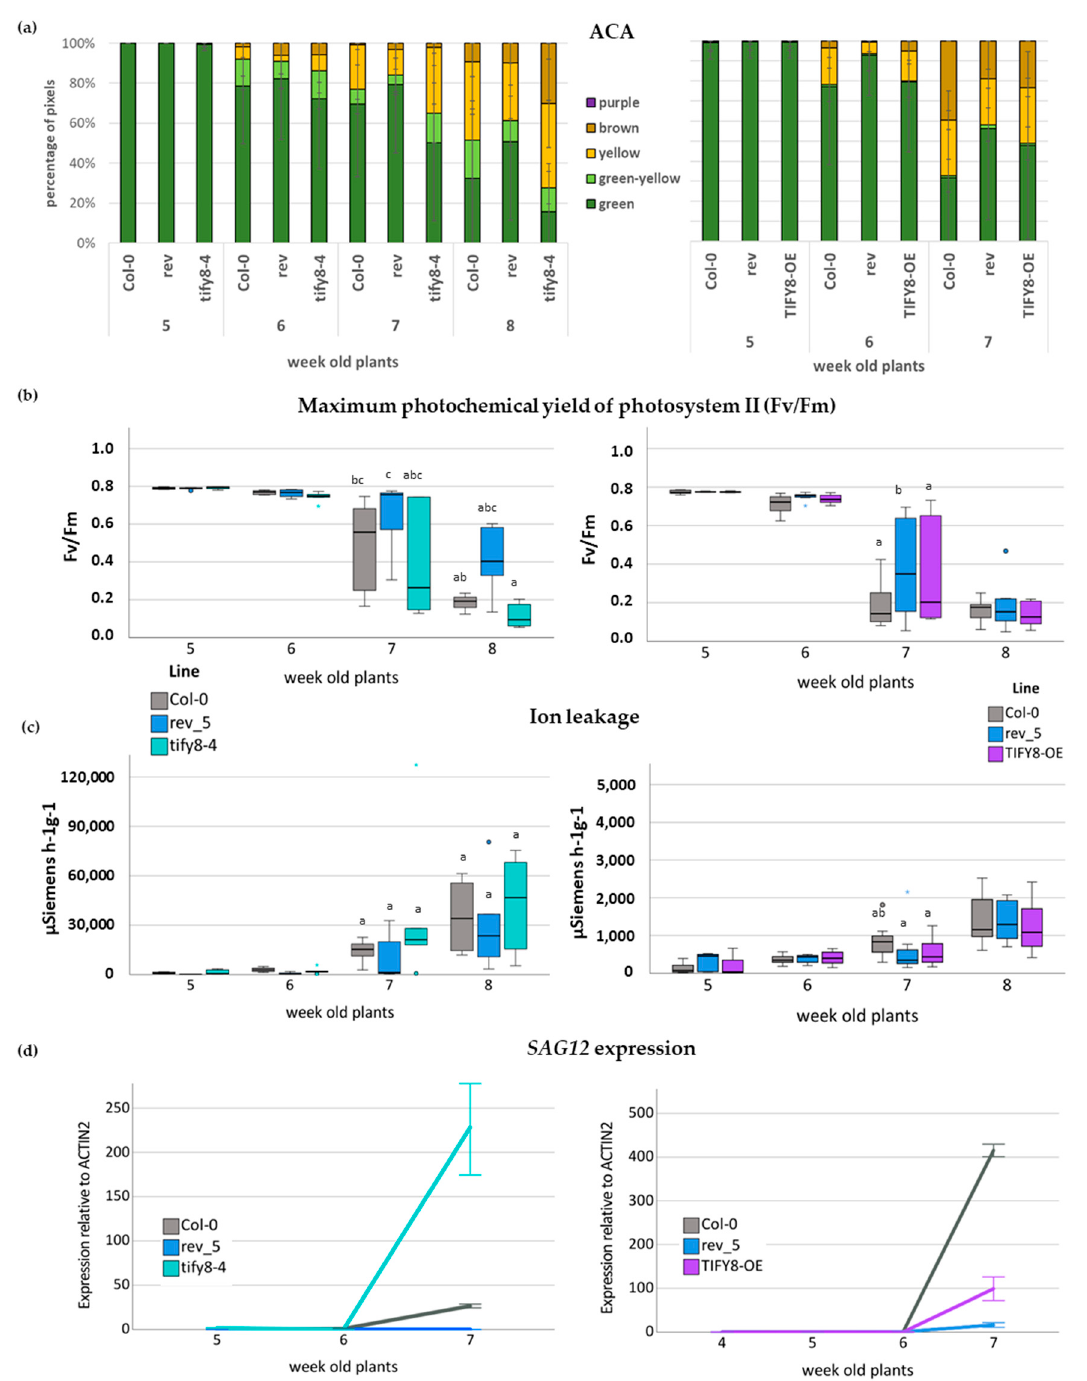
Figure 5. Photosynthetic parameters analyzed for the senescence phenotyping of tify8-4 and TIFY8 - OE compared to rev5 mutants and wildtype Col-0 plants. ( a ) The Automated Colorimetric Assay (ACA) to categorize the color of individual leaves of at least six plants pixelwise into five categories: green, green-yellow, yellow, brown, and purple. The percentage of each group with respect to total pixel number of all leaves (1–10) is presented ( n = 6). ( b ) Boxplot of Fv/Fm values measured with PAM for leaves No. 5 of 4- to 7-week-old plants ( n = 6–8). ( c ) Boxplot of the decrease in solute retention determined through ion leakage in leaves No. 4 of 4- to 7-week-old plants ( n = 6–8). One- way ANOVA test was performed, lowercase letters indicate significant differences among groups ( p ≤ 0.05). ( d ) Gene expression of the senescence-associated marker genes SAG12 was analyzed by qRT-PCR and normalized to the expression of the ACTIN2 gene (mean values ± SD, n =